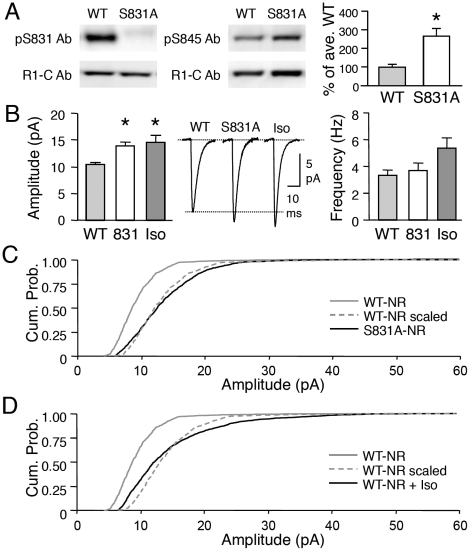
Abnormally enhanced GluR1-S845 phosphorylation and synaptic transmission in GluR1-S831A mutants.
(A) Left: Example immunoblots of WT and GluR1-S831A mutant visual cortex samples. Note the lack of phosphorylated S831 (pS831) signal (upper left), while normal expression of GluR1 (as measured with GluR1-C terminal Ab, bottom left blot). S831A mutants display a significant increase in the remaining GluR1-S845 phosphorylation (example blots in the middle panel, quantification in the right graph). *: p<0.01, t-test. (B) Average mEPSC amplitude is increased in S831A mutants (labeled 831) as well as in WT visual cortex slices treated with isoproterenol (Iso). Middle panel: average mEPSC traces from each group. Right panel: Isoproterenol treated group showed a trend of an increase in mEPSC frequency, which did not reach statistical significance (p>0.05, one-factor ANOVA). *: Significantly different from WT at p<0.01 with Fisher's PLSD posthoc test after a one-factor ANOVA. (C) GluR1-S831A mutation did not cause multiplicative scaling of mEPSCs. The amplitude of mEPSCs of S831A-NR (black solid line) shifted to larger values compared to WT-NR (gray solid line). Amplitudes of individual mEPSCs recorded from WT-NR were multiplied by a scaling factor (1.4) to match the average mEPSC amplitude to that of S831A-NR to generate the WT-NR scaled (gray dotted line). However, the cumulative probability curve of WT-NR scaled did not superimpose that of S831A-NR (p<0.01, Kolmogrov-Smirnov test). This suggests that the increase in mEPSC amplitude in GluR1-S831A mutants is not due to multiplicative scaling. (D) Treating WT-NR visual cortex slices with isoproterenol (WT-NR+iso, black solid line) increased mEPSC amplitude as shown by a rightward shift in the curve compared to control WT-NR (gray solid line). We multiplied the amplitude of mEPSCs from WT-NR with a scaling factor (1.5) to match the average mEPSC amplitude of isoproterenol treated group to generate the WT-NR scaled (gray dotted line). The cumulative probability curve of the WT-NR scaled did not overlap with the WT-NR+Iso group (p<0.01, Kolmogrov-Smirnov test).